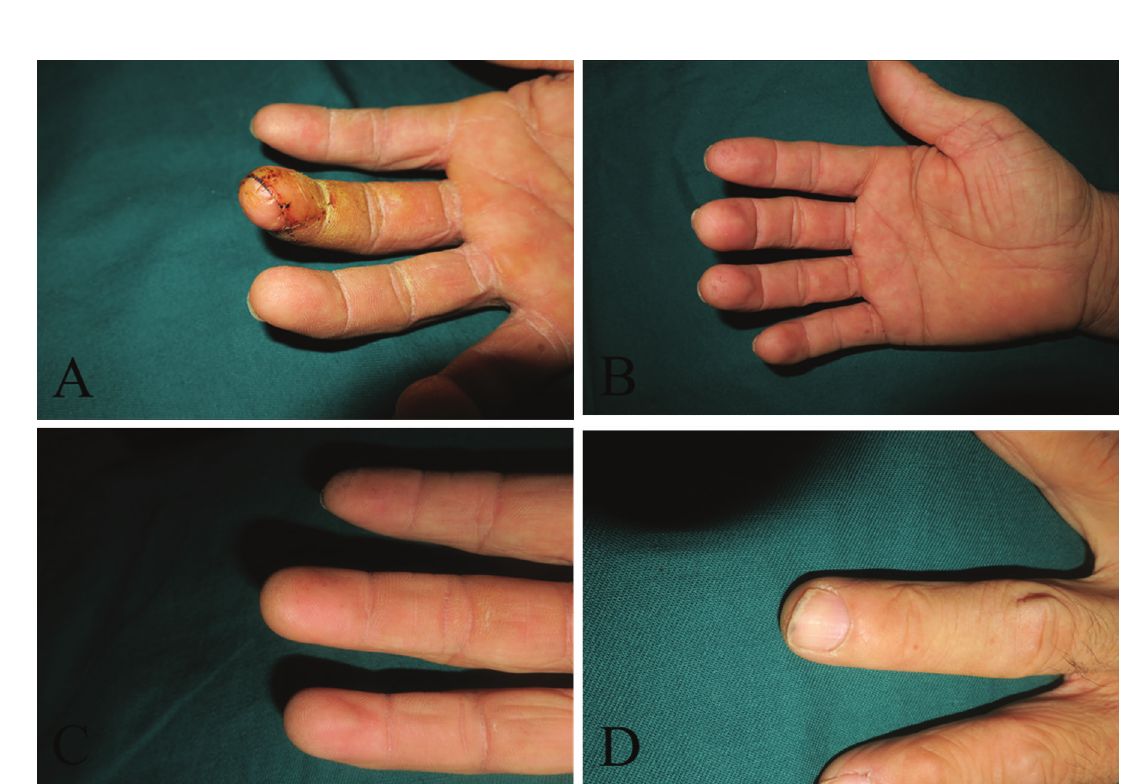
Figure 3 - In this patient, the flap appearance 3 weeks (A), 6 months (B), 1 year (C) and 2 years (D) after transplantation. The appearance was satisfactory, and the patient had a normal nail